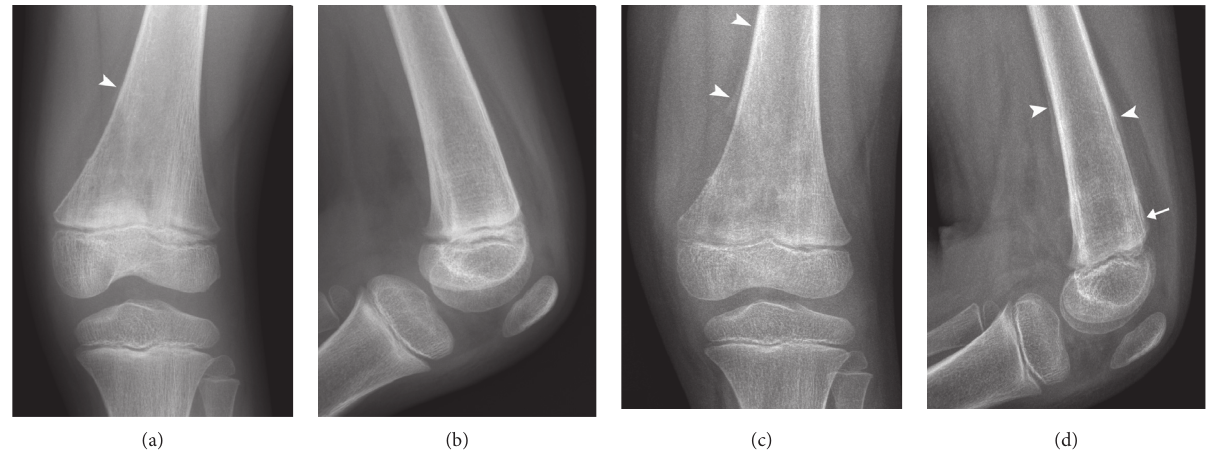
Figure 1: Anteroposterior and lateral knee radiographs at presentation (a, b) and 15 days later (c, d) show interval progressive medullary- based eccentric lytic change with a wide zone of transition, aggressive (Codman’s triangle) periosteal reaction (arrowheads), and subtle cortical deformity